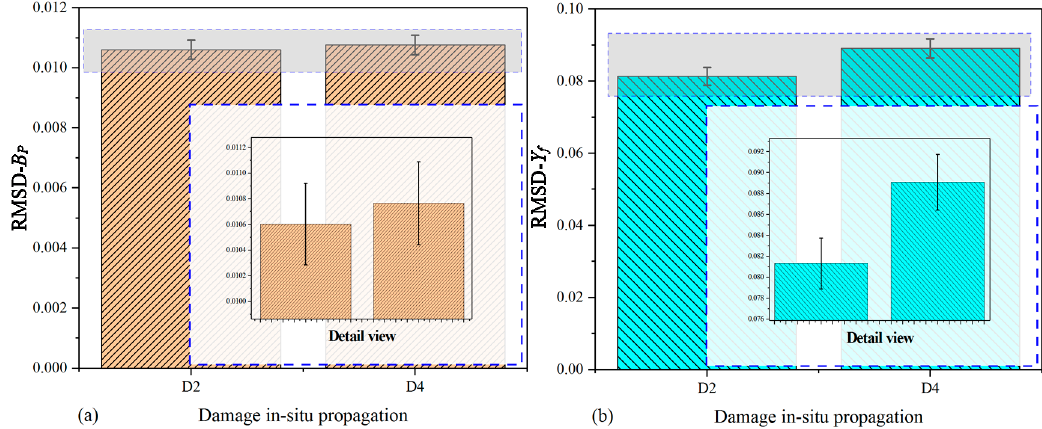
Figure 8. RMSD calculated based on imaginary part of signatures for specimen-1: ( a ) raw susceptance signatures B P , ( b ) extracted DCMI signatures Y f